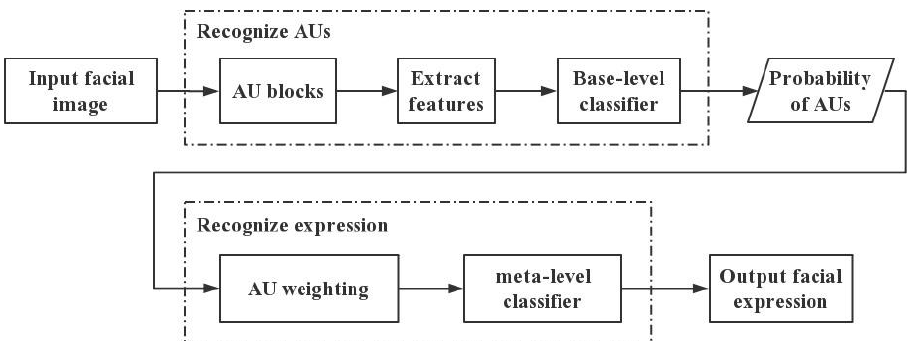
Figure 1. Flow chart diagram of the fusion-based expression recognition approach.